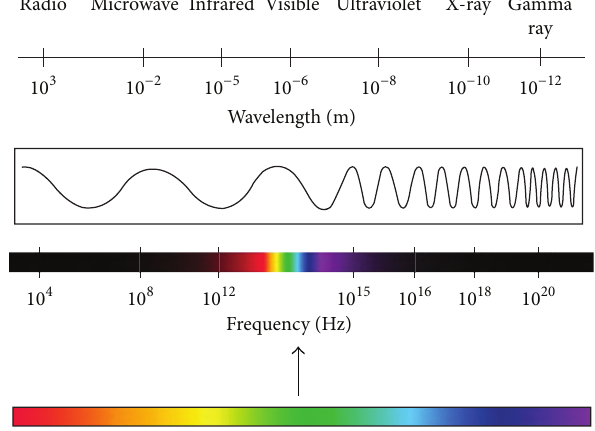
Figure 5: The electromagnetic